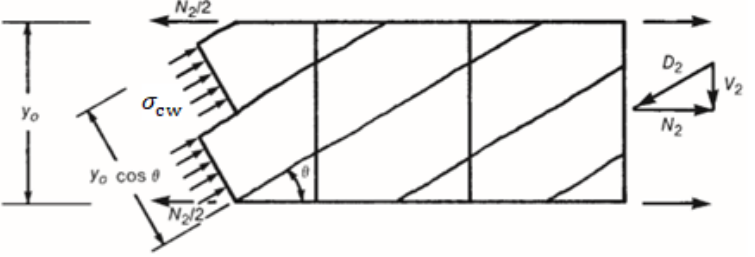
Figure 7: Section of a vertical wall of the truss detailing the chords and struts forces